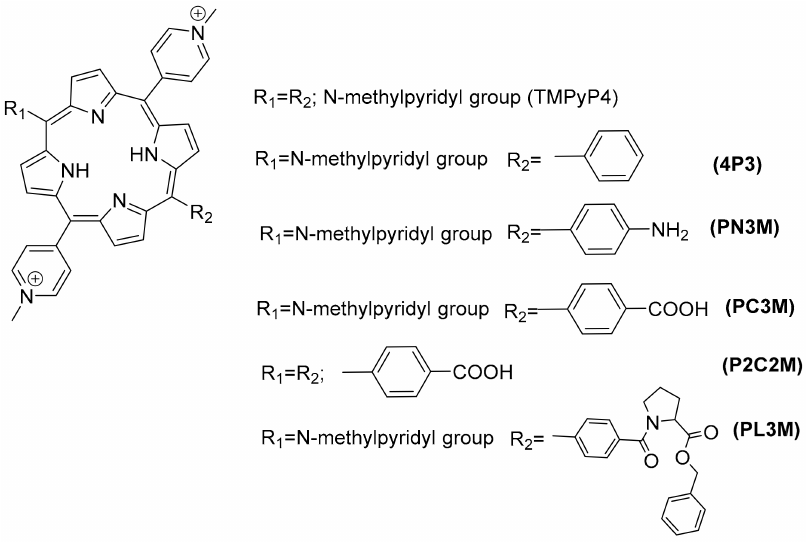
Figure 16. Structures of TMPyP4